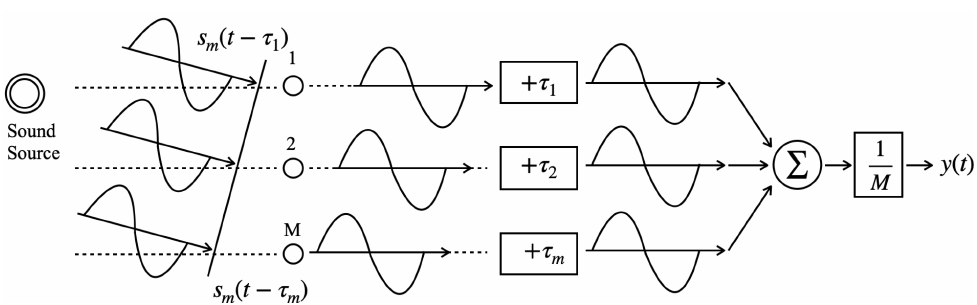
Figure 3. Delay-and-sum (DAS) beamforming in the time domain